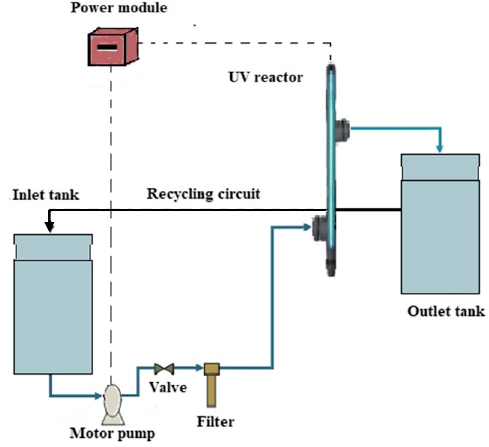
Figure 1. Schematic representation of the UV disinfection system.